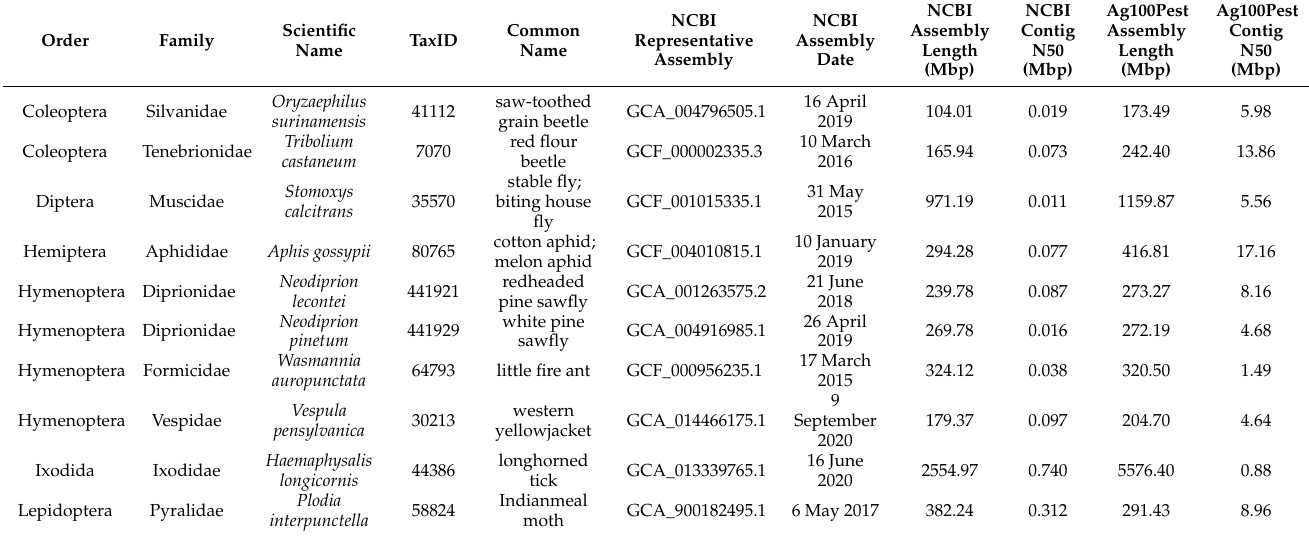
Table 2. Improvement of Ag100Pest contig assemblies over publicly available assemblies. NCBI data was accessed on 27 April